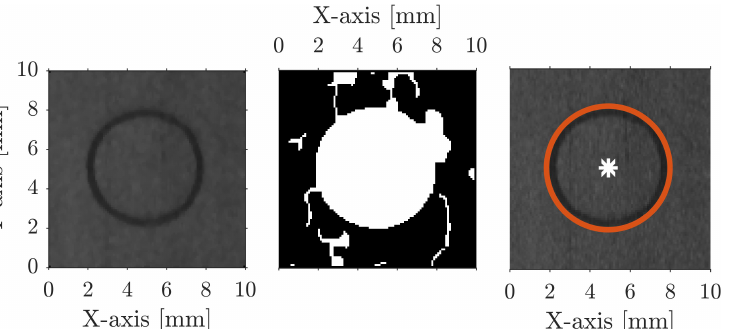
Figure 3. Acquired point cloud of n marked fiducials. The yellow arrow indicates the computed surface normal vector V s of the calibration plate.